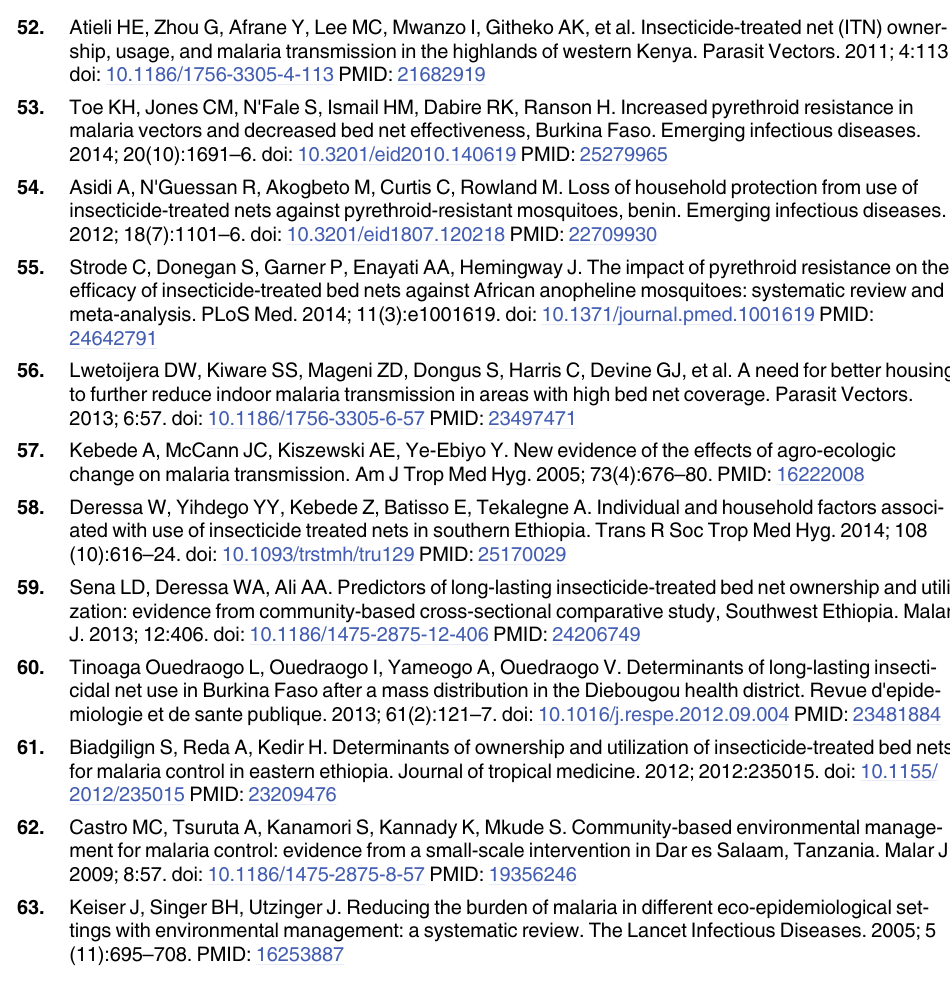
PLOS ONE | DOI:10.1371/journal.pone.0132778 July 14,